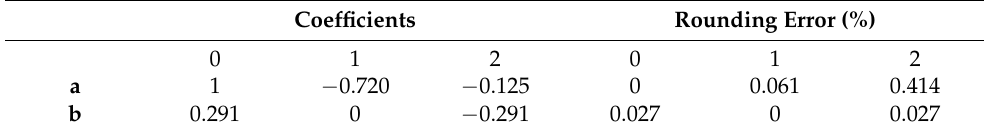
Table 2. Equivalent 4th IIR coefficients scaled by 8 2 and the percentage error introduced by integer rounding.